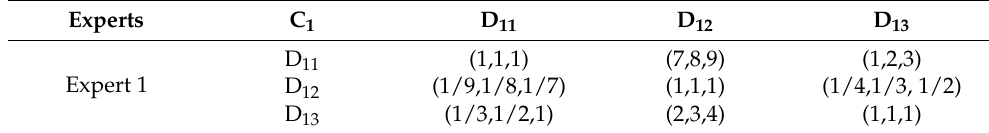
Table 5. Opinions on the importance of each indicator factor under policy-driven conditions two-by- two